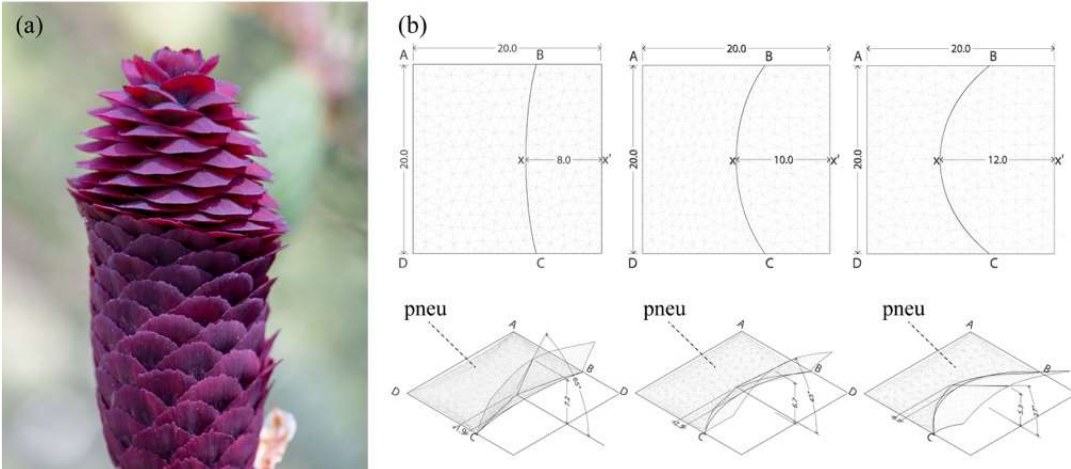
Figure 10. The movable scales of ( a ) the Purple Cone Spruce inspired ( b ) a sensitivity analysis of pneumatically driven curved-line folding models. All models were made using Daniel Piker’s plugin Kangaroo Physics for Rhinoceros 3D by McNeel & Associates. When actuated with the same amount of pressure, models with a lower curvature in the fold responded quicker and showed a larger flapping motion, while models with a higher curvature in the fold were less responsive to actuation and moved significantly slower. (Photo on the left shown with the permission of Jessica Rosenkrantz).